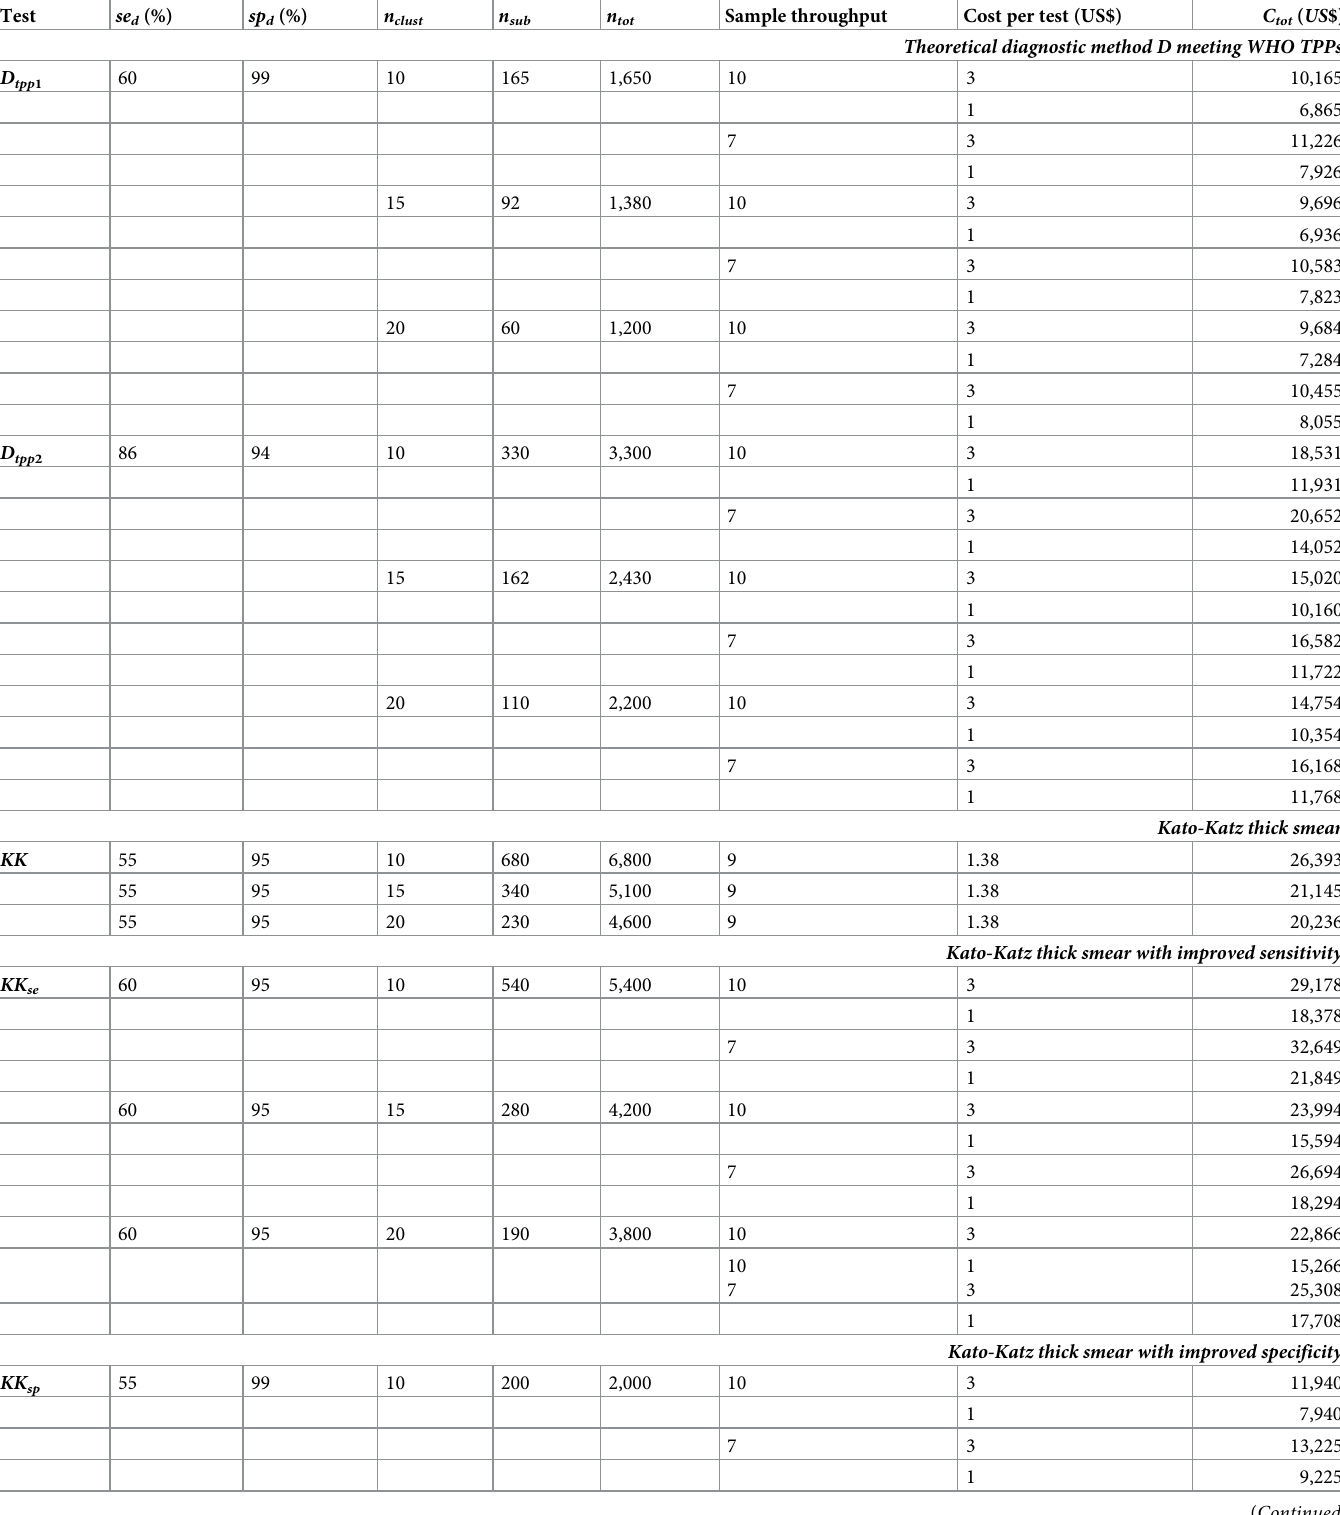
Table 3. The use of the 2-stage LQAS framework to develop guidelines and strategic choices in